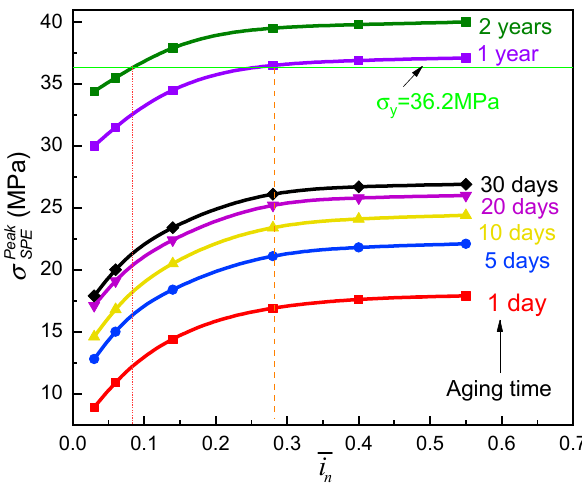
Figure 10. E ff ect of dimensionless surface current density ( i n ) on the peak tensile Figure 10. Effect of dimensionless surface current density (